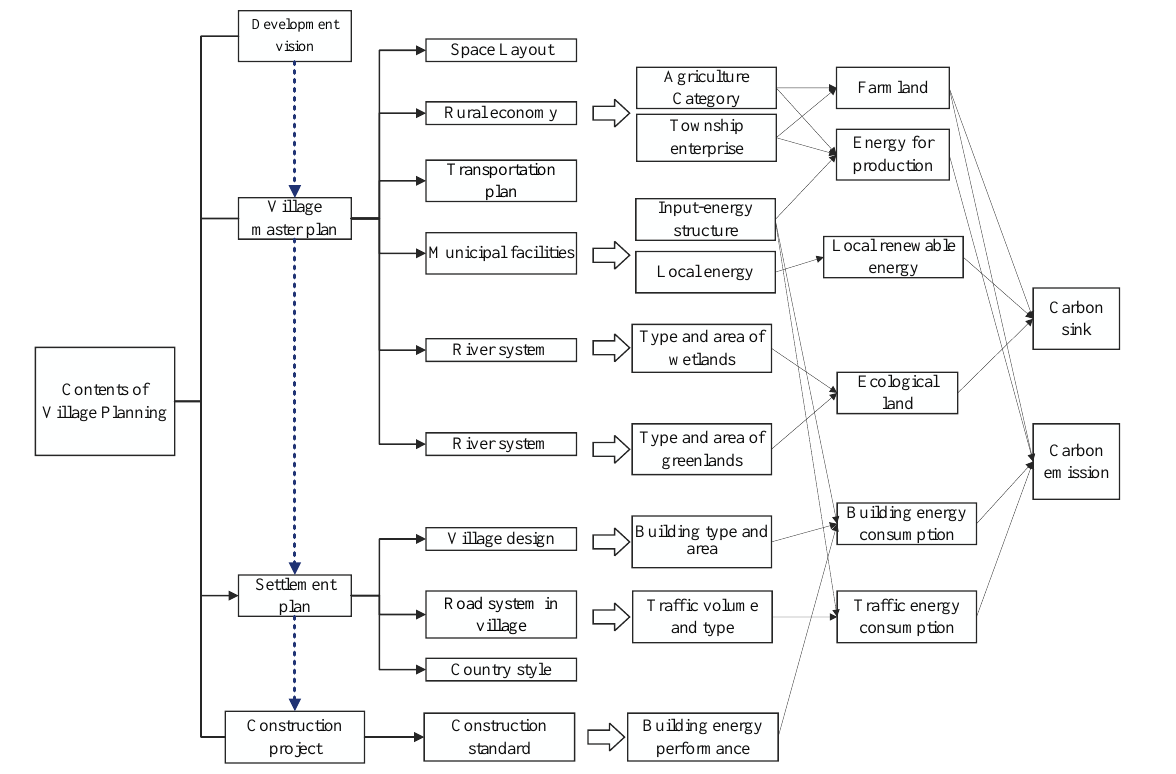
Figure 1. Relationships between village planning content and carbon emissions.